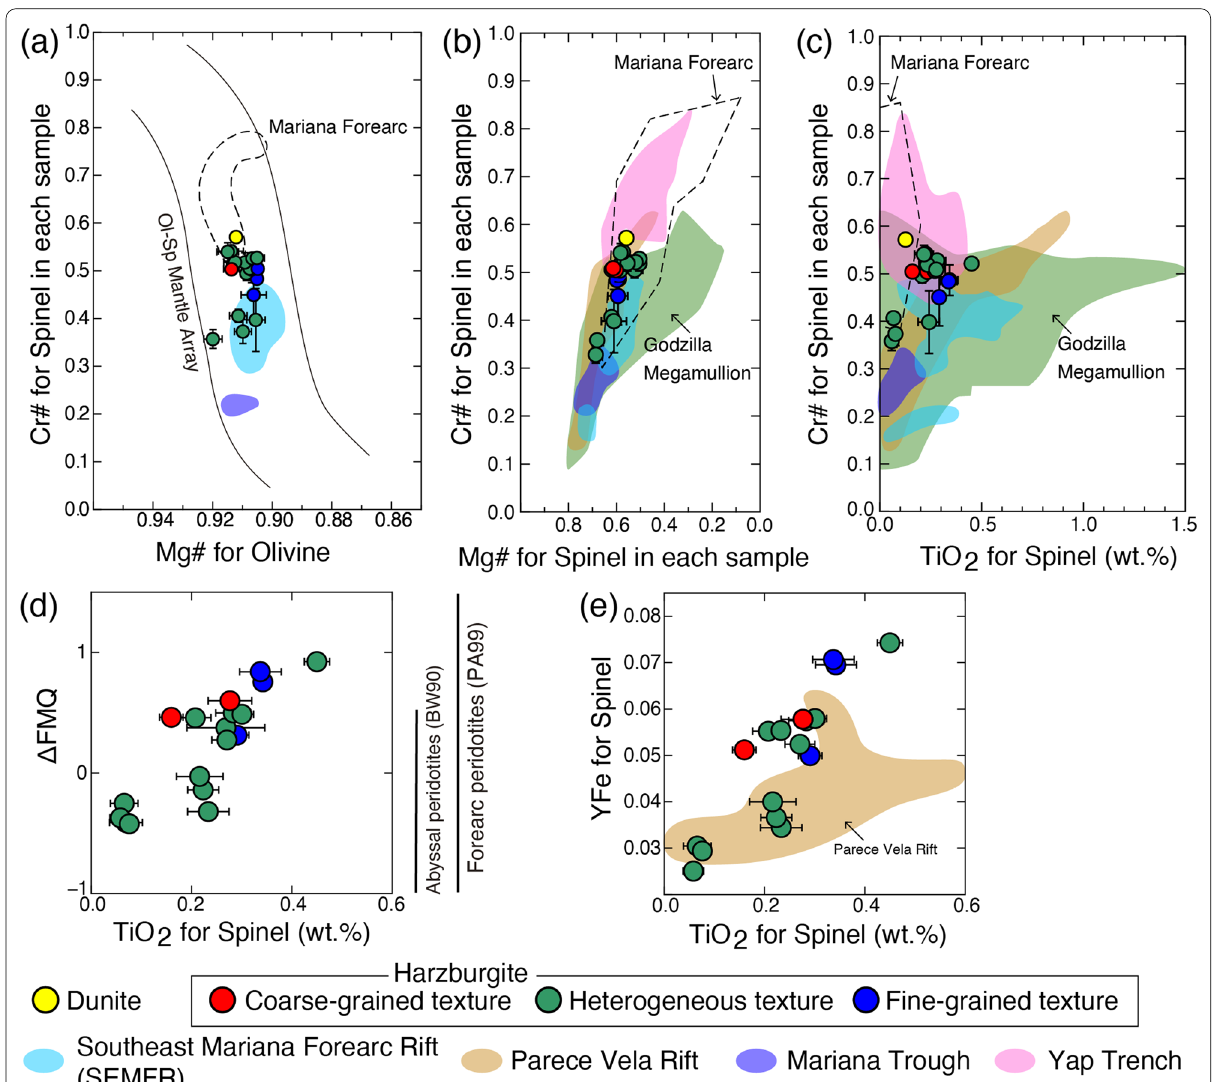
Fig. 8 Compositional data for dunite (red) and harzburgite (green). Error bar is the deviation of average values. Green filled circles indicate harzburgite, and red filled circles indicate dunite. a Average Mg# of olivine vs. average Cr# of spinel in the 139°E Ridge peridotites. The region between the two solid lines is the olivine–spinel mantle array (OSMA), where mantle‑derived spinel peridotites plot (Arai 1994). b Average Mg# vs. average Cr# for spinel grains in the 139°E Ridge peridotites. c Average TiO 2 values vs. average Cr# for spinels in the 139°E Ridge peridotites. d Average TiO 2 contents of spinel vs. ΔFMQ values for the 139°E Ridge peridotites. ΔFMQ values were calculated from the major element compositions of olivine and spinel (Ballhaus et al. 1990). ΔFMQ values for abyssal peridotites (Bryndzia and Wood 1990) and forearc peridotites (Parkinson and Arculus 1999) are shown in the vertical lines. e Average TiO 2 values vs. Y Fe values for spinel in the 139°E Ridge harzburgites. The compositional field for the Godzilla Megamullion is shown by green domain (Loocke et al. 2013), the field for the Parece Vela Basin is shown by orange domain (Ohara et al. 2003), the field for the Mariana Trough is shown by blue domain (Ohara et al. 2002a), the field for the “Mariana Trough” outcropped in Mariana Trench is shown by cyan domain (Michibashi et al. 2009), the field for the Yap Trench is shown by magenta domain (Ohara et al. 2002b; Chen et al. 2019), and the field for the Mariana forearc is shown by a dashed line (Ishii et al. 1992; Ohara and Ishii